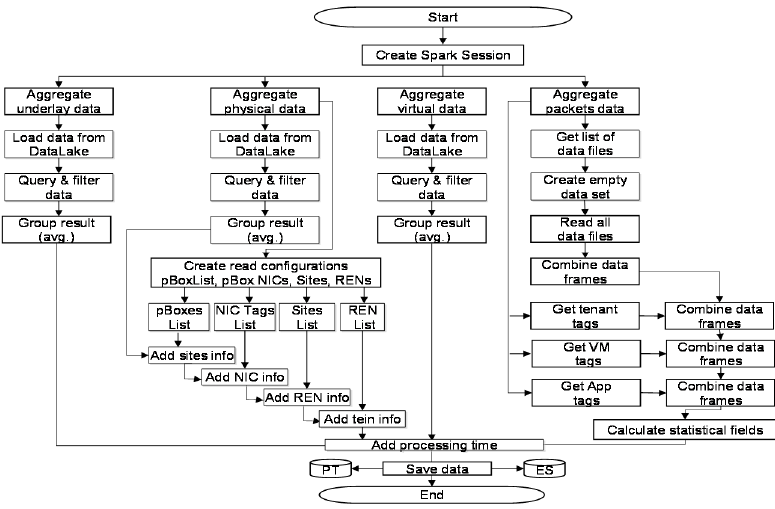
Figure 6 . Design of visibility data aggregation and tagging component. Figure 6. Design of visibility data aggregation and tagging